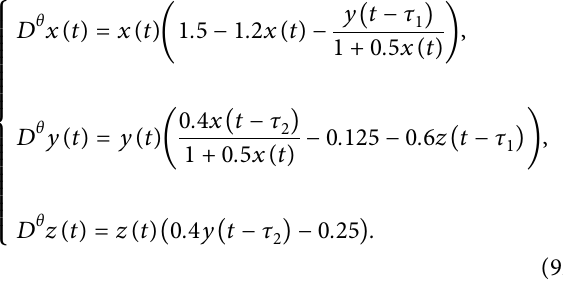
Figure 7: Case 4: the trajectories and phase diagrams of system (92) at τ